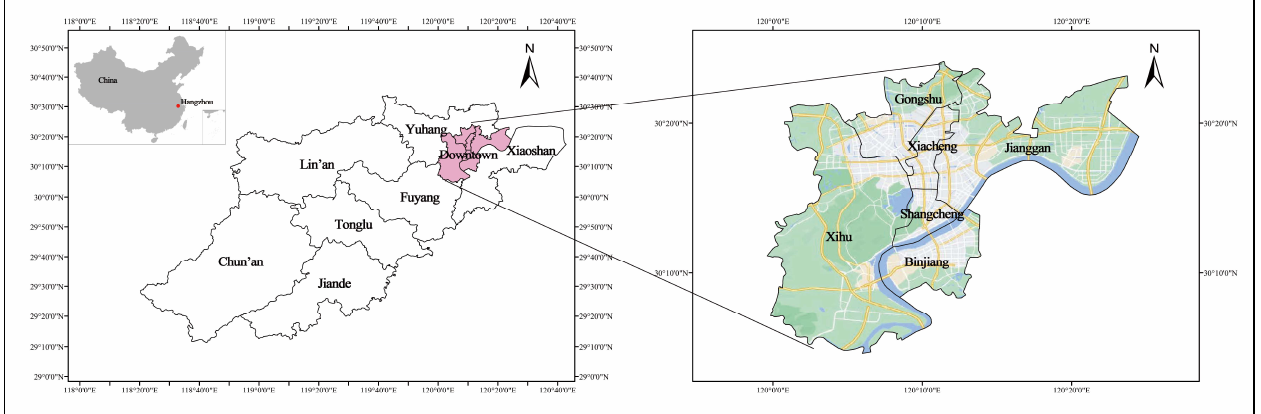
Figure 1. T he study area. Figure 1. The study